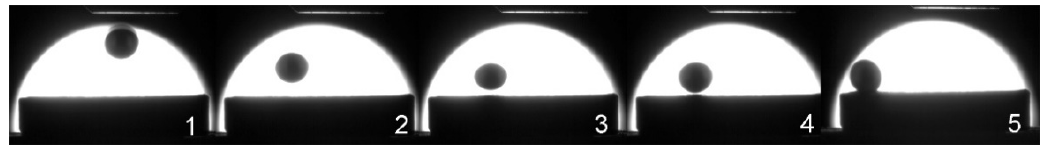
Figure 4. Photo sequence of the sessile drop experiment on Al 2 O 3 -C substrate with capillary purification of AlSi7Mg alloy—Measurement 1 .